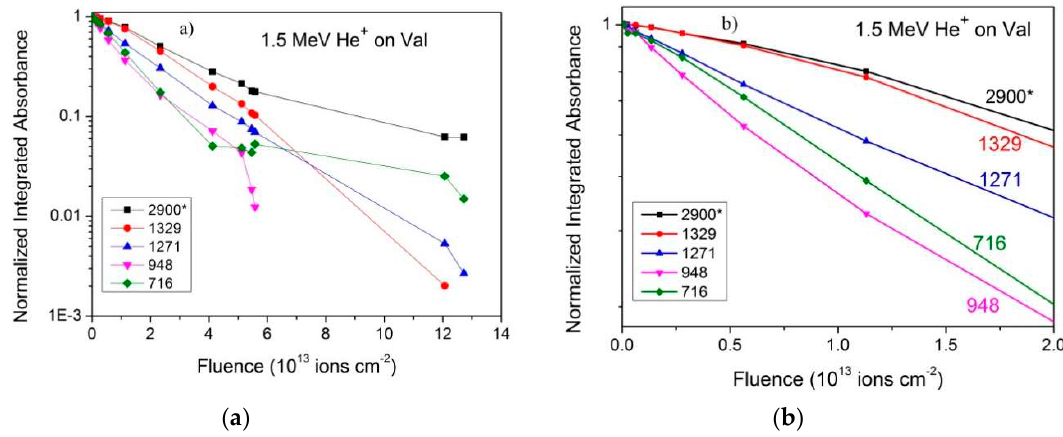
Figure 4. ( a ) Dependence on fluence of the integrated absorbance for several bands observed in the He + beam irradiation. Data are normalized to 1 at F = 0. The asterisk indicates overlapping with product’s bands. ( b ) Zoom into the low fluence region. Colored lines are guides for eyes.